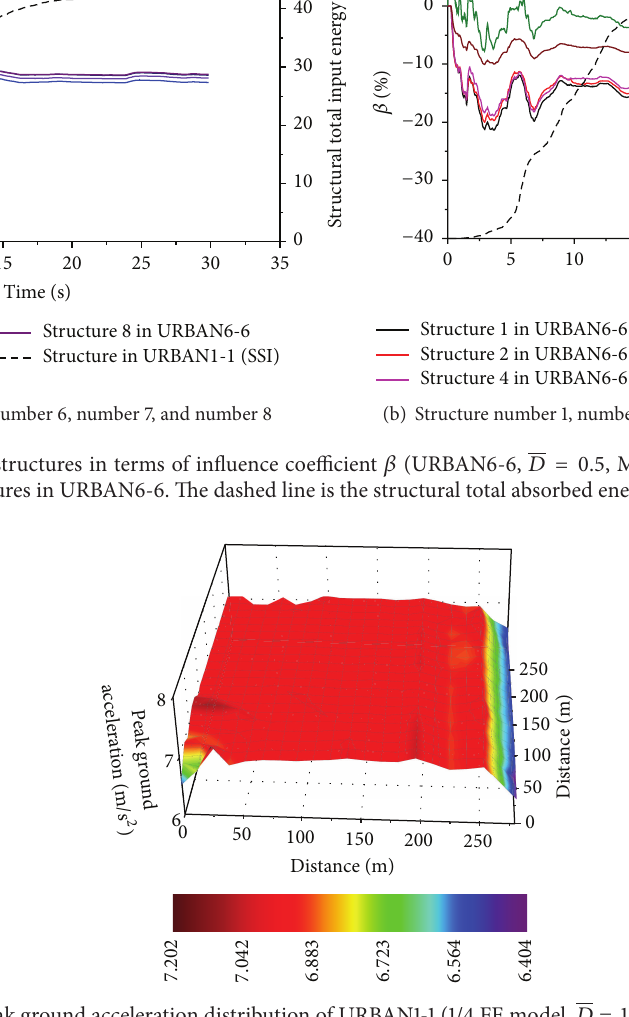
Figure 15: Peak ground acceleration distribution of URBAN1-1 (1/4 FE model, 𝐷 = 1.25 , El Centro, 𝑆𝑋 ).